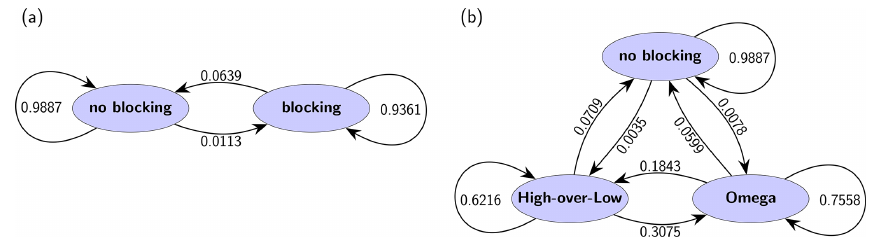
Figure 12. Graph representation of the transition matrix estimated for a Markov process (a) with two states (Eq. 17) and (b) with three states (Eq. 18) in the Euro-Atlantic region (40 ◦ W–30 ◦ E). Standard errors in the estimates are given in Tables 2 and 3.